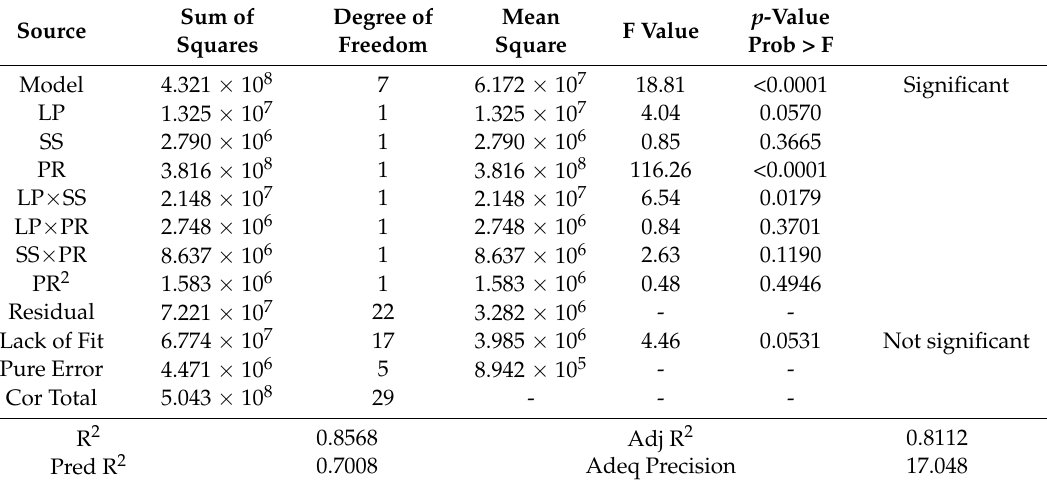
Table 6. Analysis of variance on wear